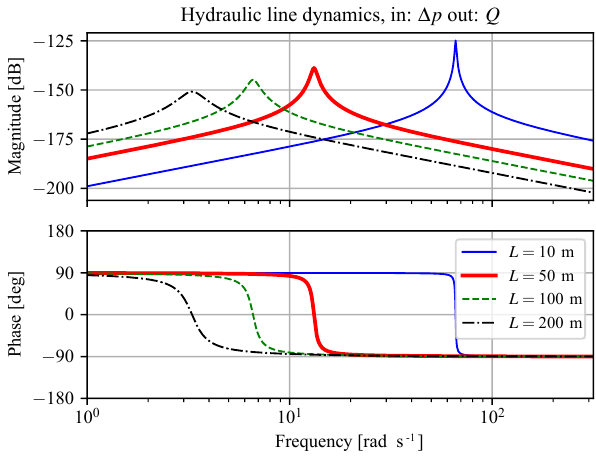
Figure 15. Bode plot of a hydraulic control volume modeled as a harmonic oscillator with pressure change (cid:49)p as input and flow Q as output. The length of the hydraulic line has a great influence on the location of the natural frequency and magnitude of the damping coefficient.